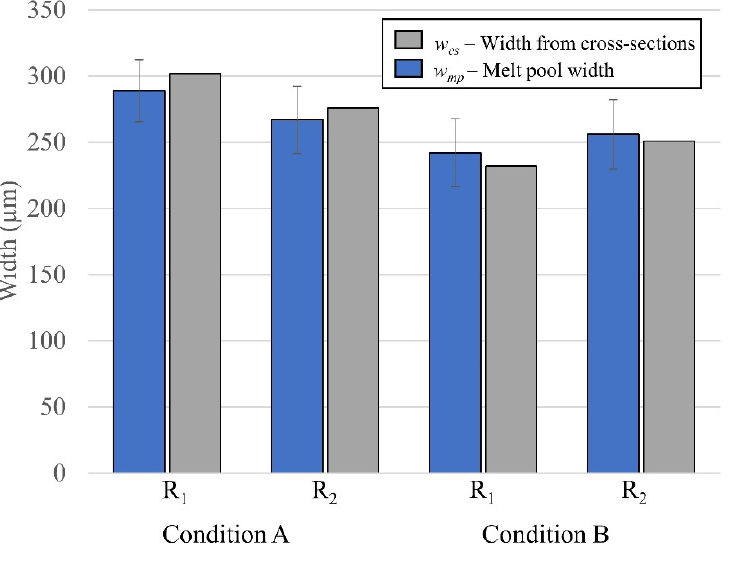
Figure 9. Molten pool width measured using the metallographic cross-sections ( w cs ) and the molten pool identification algorithm ( w mp ). Error bars are one standard deviation from the mean.